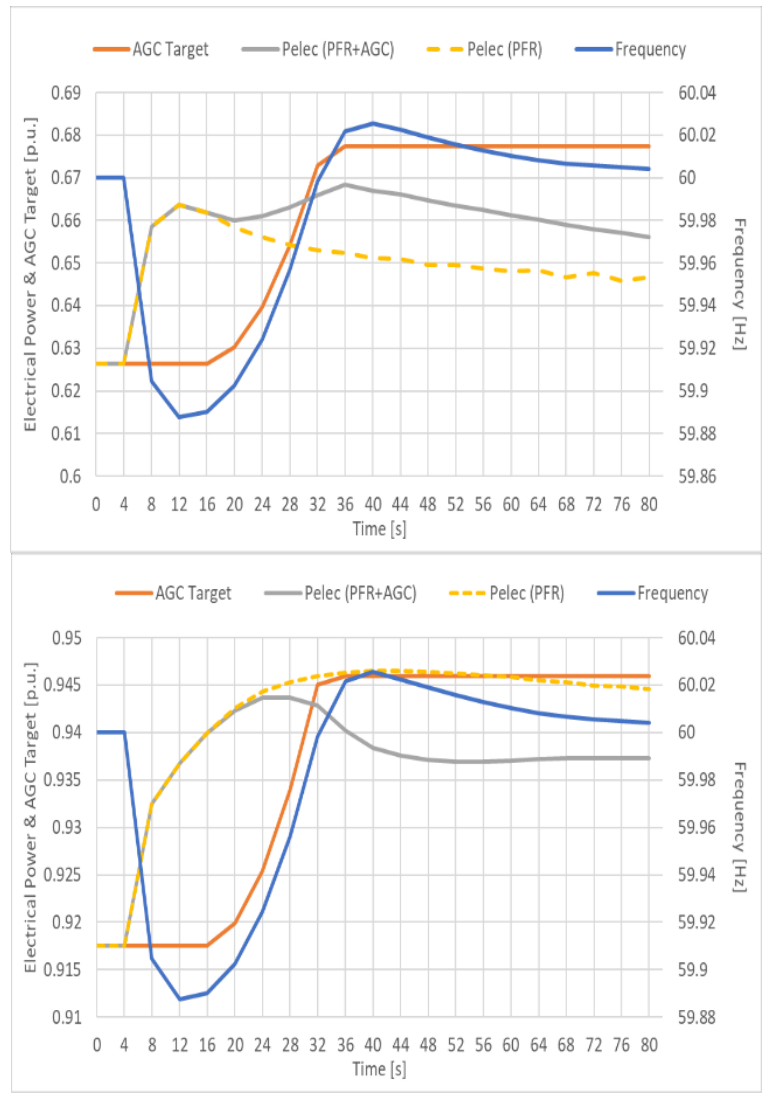
Figure 15. AGC frequency control response of GEN#1 ( upper ) and GEN#2 ( lower ).